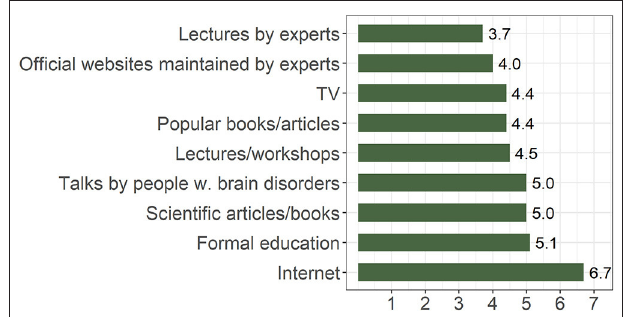
FIGURE 5 | Median ranks of answers to the question “What is your preferred manner of acquiring new knowledge about the brain, brain disease, and preventive practices?” (lower rank indicates higher preference; n = 894).